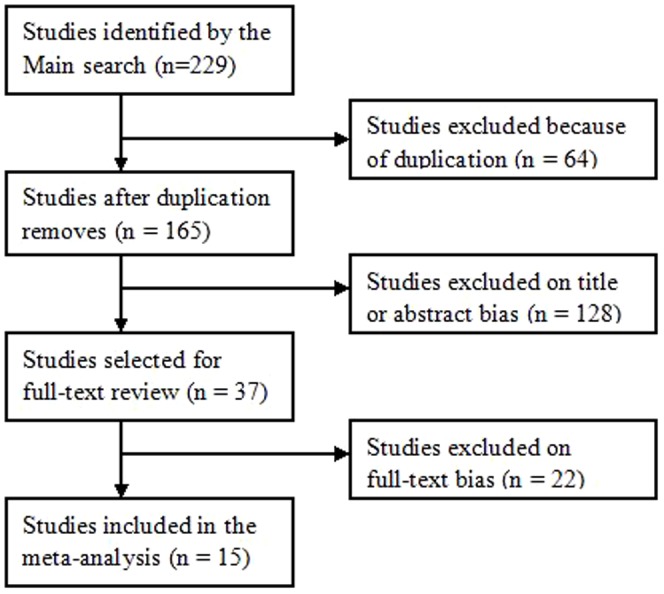
Flow diagram of included studies for this meta-analysis.